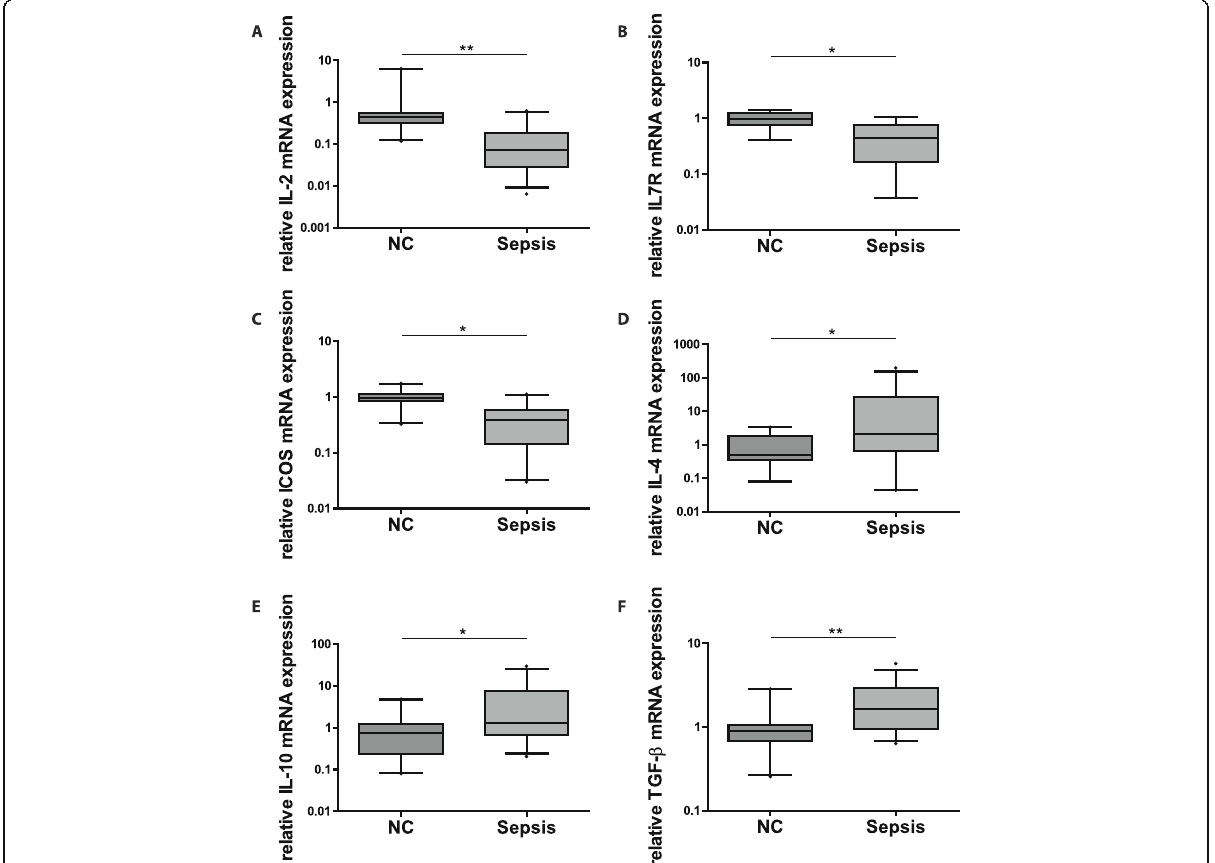
Fig. 2 T-cell immunoparalysis in sepsis. Cytokine and immune receptor expression in T-cells of septic patients as compared to healthy controls. mRNA levels of ( a ) IL-2, ( b ) IL-7R ( c ) ICOS, ( d ) IL-4, ( e ) IL-10 and ( f ) TGF-ß in Pan T-cells of septic patients and healthy controls, respectively, were measured by qPCR relative to reference genes SDHA and TBP. Data are presented as median, 25th and 75th percentile and outliers, measurements were performed in duplicates. Values represent expression relative to controls, *p <0.05, **p <0.001. Quantification cycle (Cq) values for the single cytokines and receptors were in the range of 34 (NC) and 36 (Sepsis) for IL-2, 24 (NC) and 25 (Sepsis) for IL7R, 32 (NC) and 33 (Sepsis) for ICOS, 35 (NC) and 32 (Sepsis) for IL-4, 35 (NC) and 33 (Sepsis) for IL-10, 25 (NC) and 24 (Sepsis) for TGF-ß,